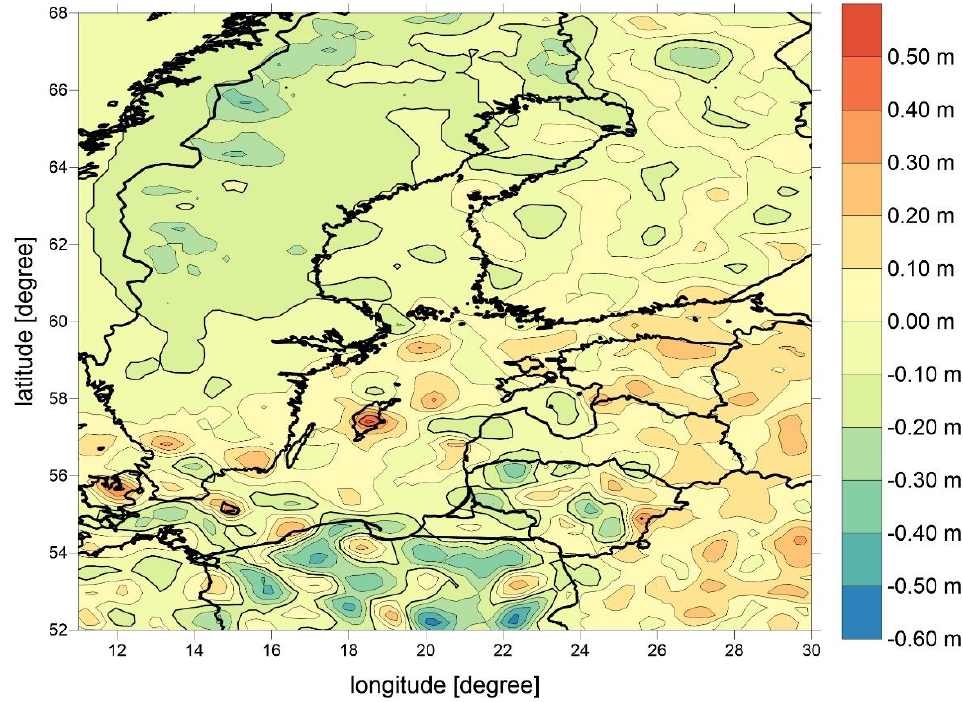
Figure 7. Residual cogeoid, in meters, in the case of the GOCO06s geopotential